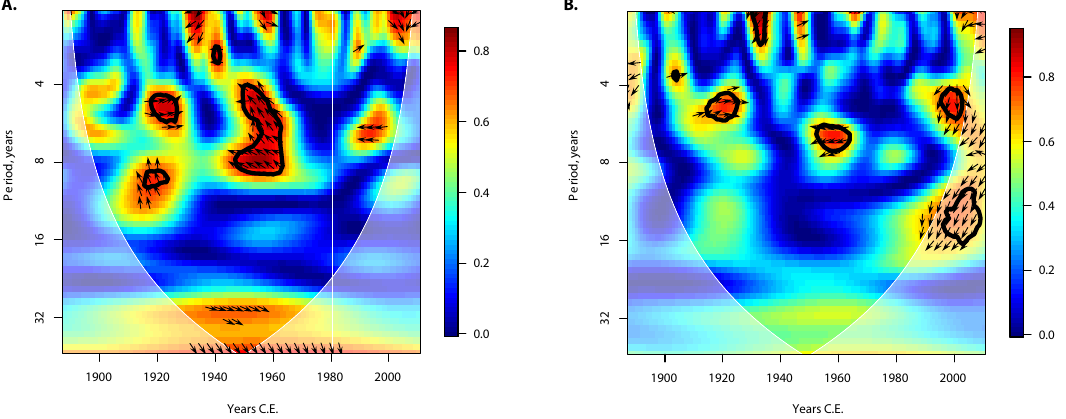
Years C.E. Figure 9. Wavelet coherence plots between annually resolved geographic South Pole δ D and the SIO (a) and SWP (b) surface pressure extracted from the 20CR (Compo et al., 2011). Major periodicities (95% confidence) are defined by solid black contours; the white dashed lines denote the cone of influence. Arrows indicate relative phase with angle measured anticlockwise from in-phase (pointing to the right) through SIO and SWP pressure leading South Pole δ D (temperature) in quadrature (pointing upwards) to anti-phase (pointing